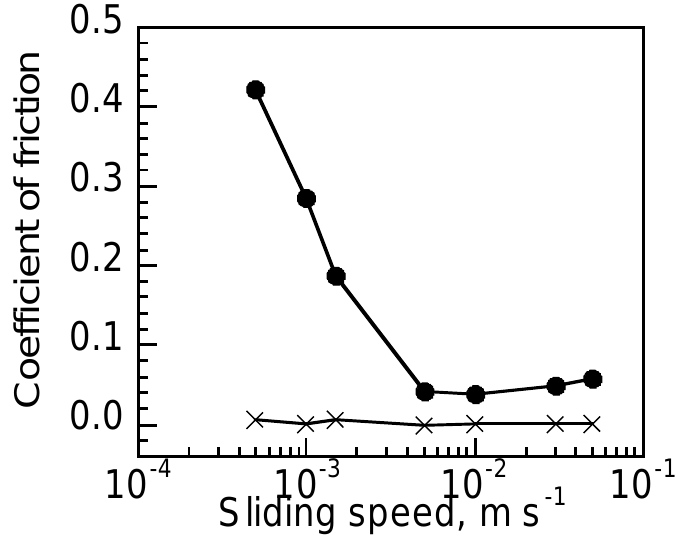
Figure 5. Sliding speed dependency of COF measured at glass/DNIG-1 (circle) and glass/DNIG-2 (triangle).